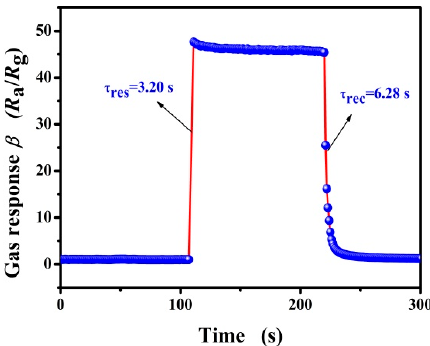
Figure 6. The typical response and recovery times of the sensor based on 5 mol % Pd-functionalized SnO 2 nanofibers at the optimal operating temperature of 260 °C for 3000 ppm butane.